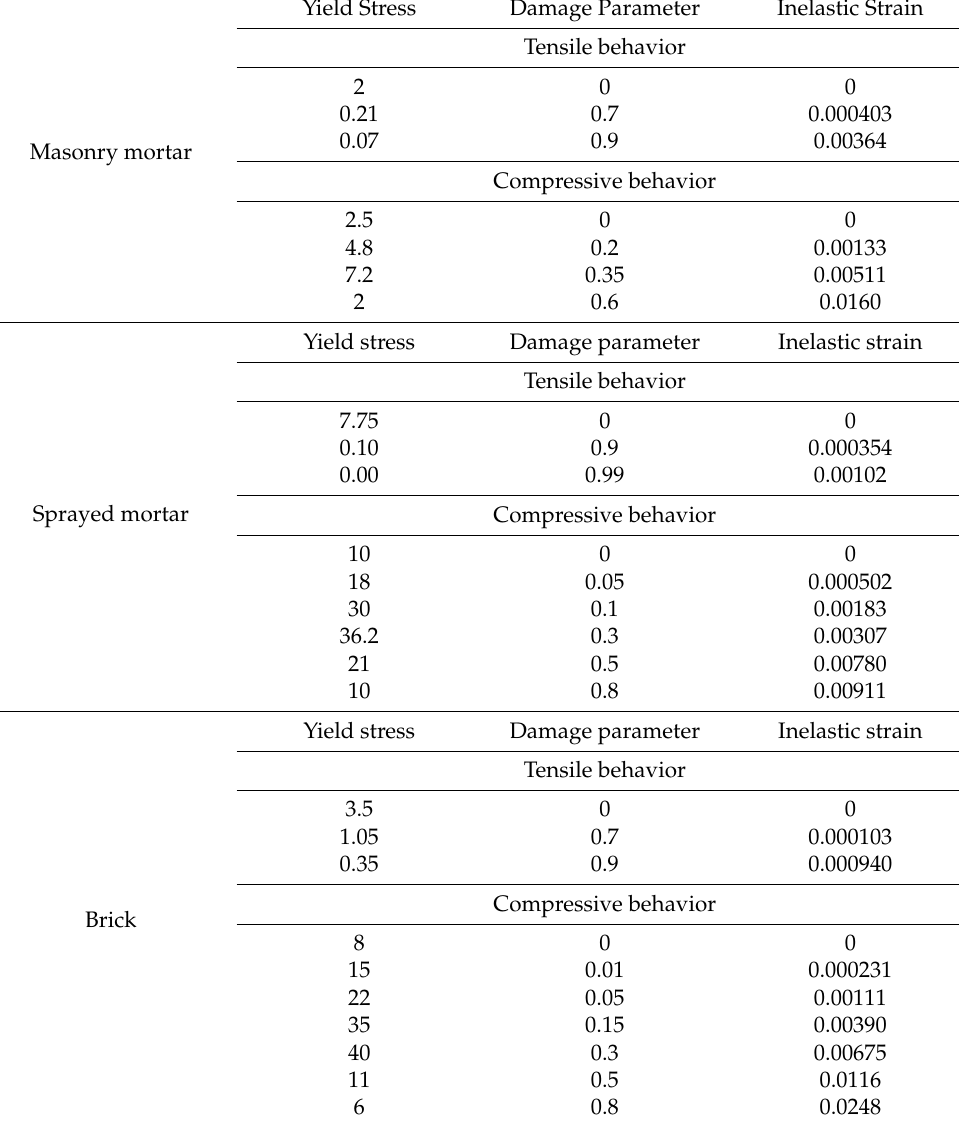
Table 11. Summary of CDP